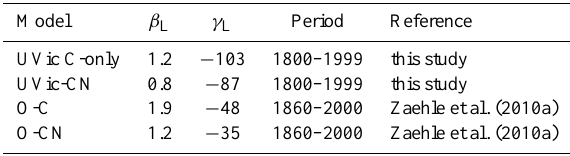
Table 7. Climate sensitivities β L in (PgCppmv − 1 ) and γ L in (PgCK − 1 ) of the land C pool in UVic C-only and UVic-CN com- pared to other